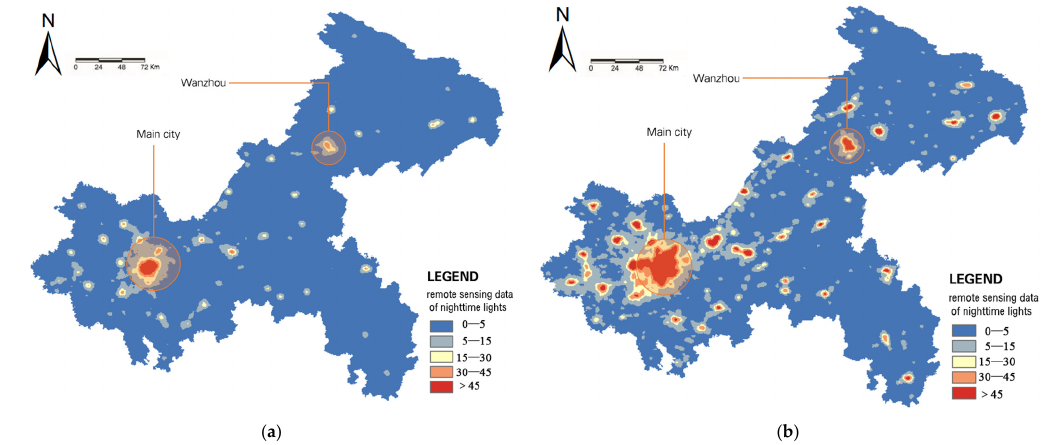
Figure 9. Changes in remote sensing data of night-time lights in Chongqing; ( a ) remote sensing of night lights in 2000; ( b ) remote sensing of night lights in 2020.